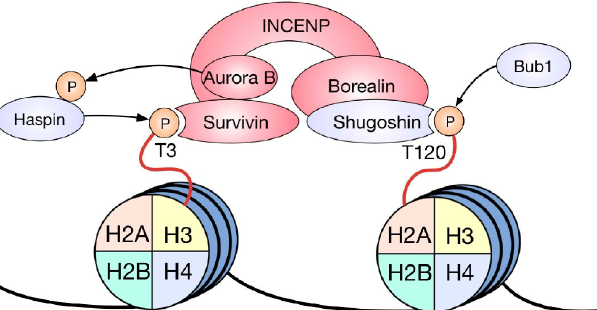
Figure 2. HPTM-dependent CPC recruitment. H3T3 and H2AT120 phosphorylations, by Haspin